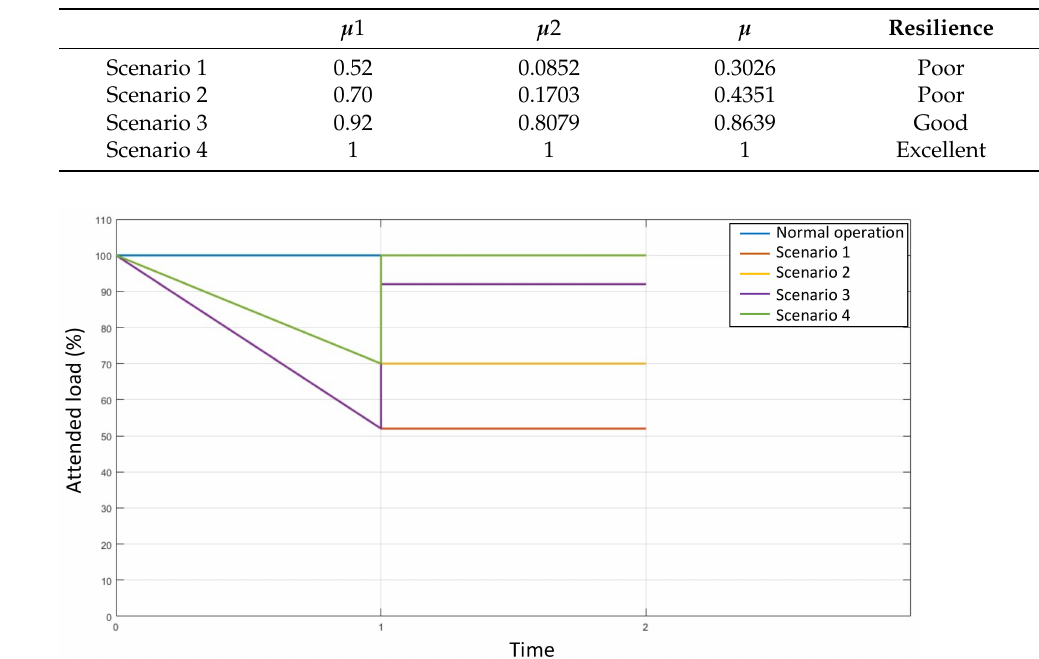
Table 14. Resilience metrics.